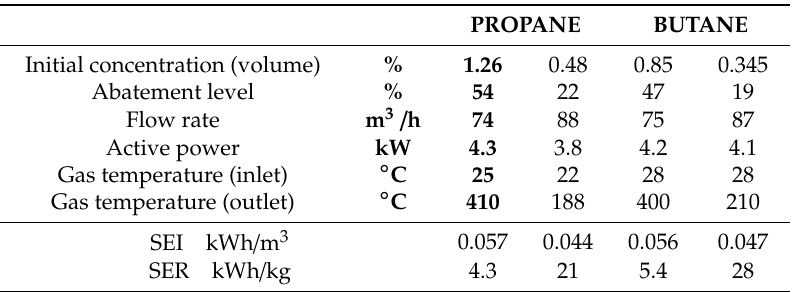
Table 2. Laboratory experimental results [53].